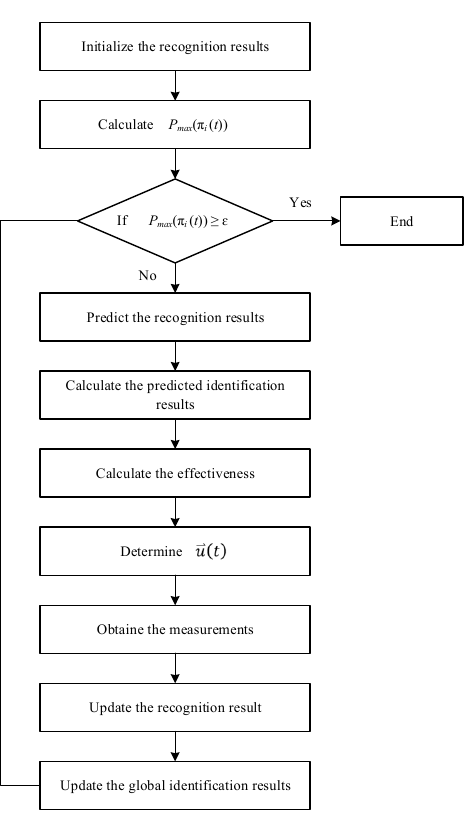
Figure 3. The flow chart of the proposed